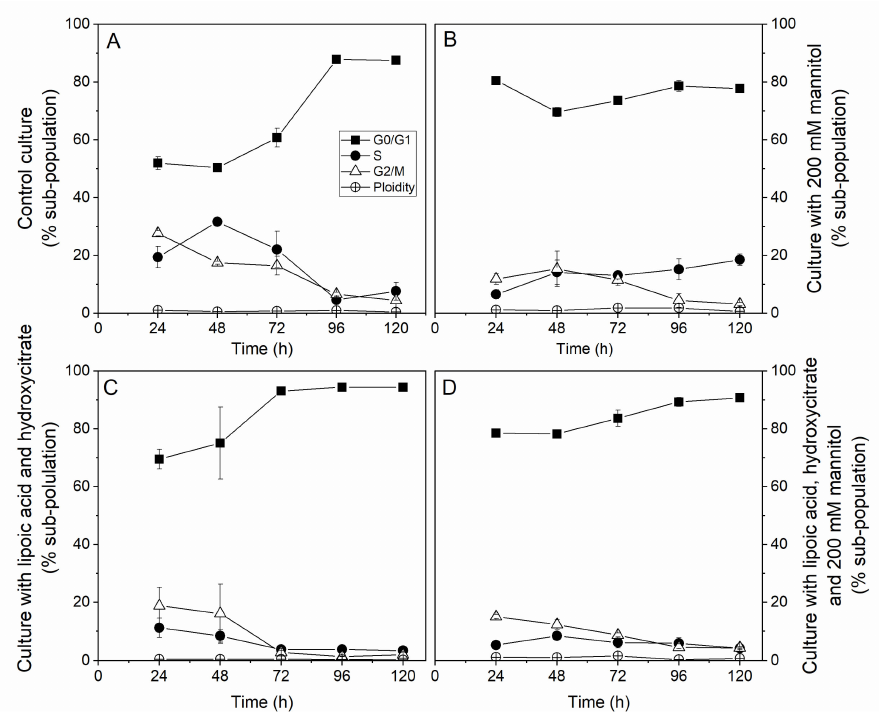
Figure 2. Effects of hyperosmotic culture conditions combined with lipoic acid and hydroxycitrate drugs on CHO cell cycle distribution. Experimental results for the shaken flask batch cultures in the GO/G1 phase (filled squares), the S phase (filled circles), the G2/M phase (empty triangles), and in the ploidy state of cells (empty circles) (n = 30) in: ( A ) control conditions; ( B ) high osmolarity conditions induced with 200 mM D-mannitol; ( C ) control conditions with the addition of 8 µ M alpha- lipoic acid (ALA) and 300 µ M calcium hydroxycitrate (HCA); and ( D ) high osmolarity conditions with the addition of 8 µ M ALA and 300 µ M